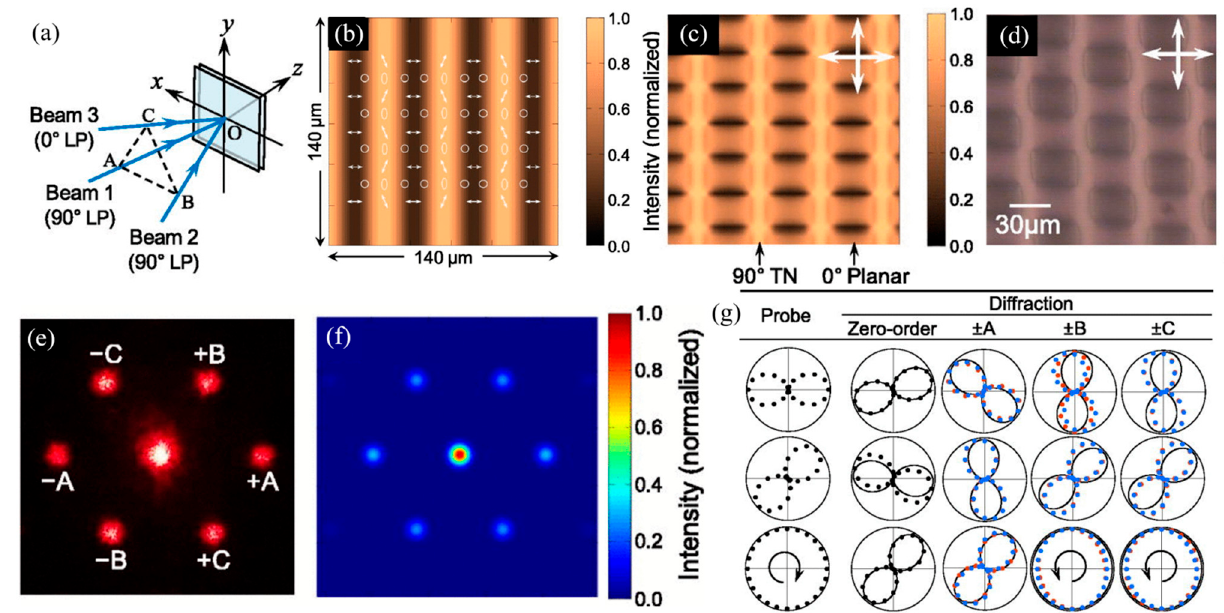
Figure 5. ( a ) Arrangement configuration of three interference beams. ( b ) Simulated intensity and polarization states of the interference field. ( c ) Simulated and ( d ) experimental observation of the LC texture by POM. ( e ) Experimental and ( f ) simulated diffraction pattern with RCP incident light. ( g ) Polar plots of the light polarizations. Lines: Simulation results; Scattered dots: Experiment results. Reproduced from Reference [37] with permission from AIP Publishing.